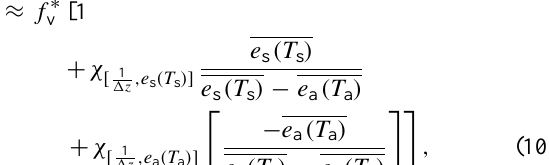
; (b) D v , 1 ; (c) 1 , 1 ; (d) D v , e s (T s ) ; (e) D v , e a (T a ) ; (f) 1 1z 1z T a T a